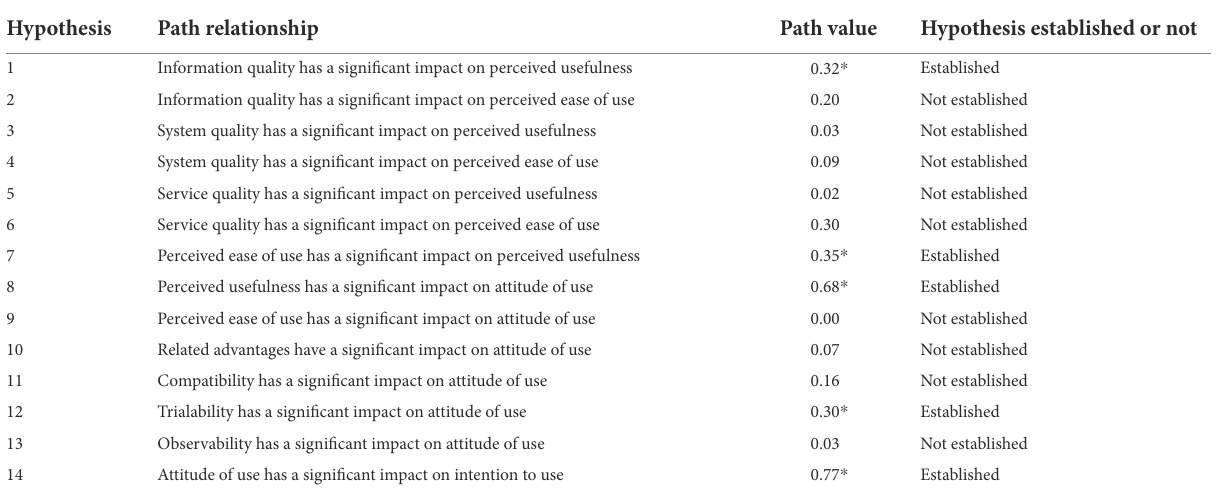
TABLE 9 Empirical results of research